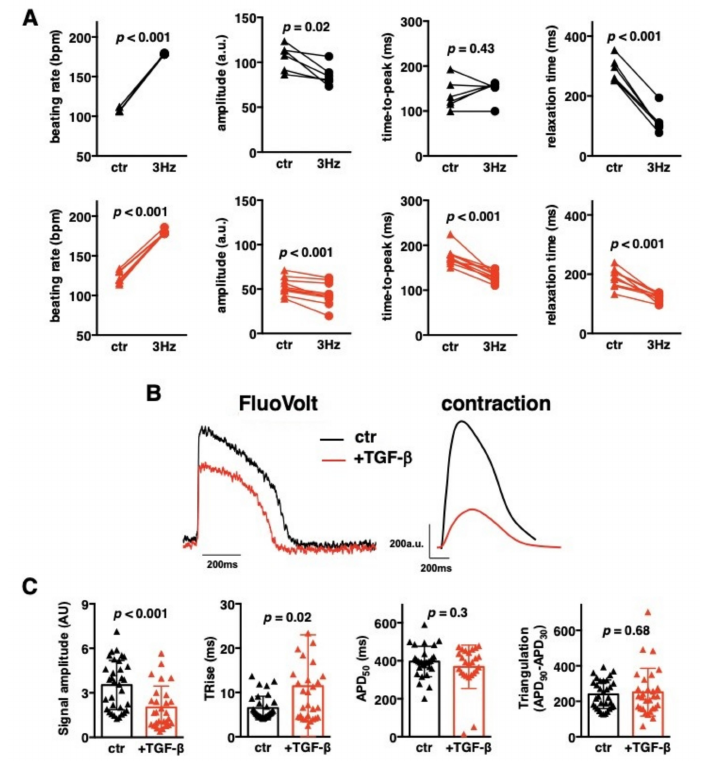
Figure 6. Cardiac microtissue electrophysiology. iCMs:fCFs microtissues were cultured in the presence (red) or absence (black) of TGF- β 1 (10 ng / mL) for 10 days. Panel ( A ) shows quantifications of the contraction parameters recorded during spontaneous contractile activity (triangles, ctr) and then upon electrical stimulation with 3 Hz (circles, 3 Hz). Each dot represents data for one microtissue at the indicated condition, lines match data obtained from the same microtissue. p values were calculated with the paired Student’s t -test. Panel ( B ) illustrates representative action potentials recorded with FluoVolt probe (left) and the respective contractions (right). Quantifications of action potential parameters are shown in panel ( C ). Graphs show cumulative data of 3 independent experiments. Each dot represents data for one microtissue. p values were calculated with the Student’s t -test. APD—action potential duration, TRise—depolarisation